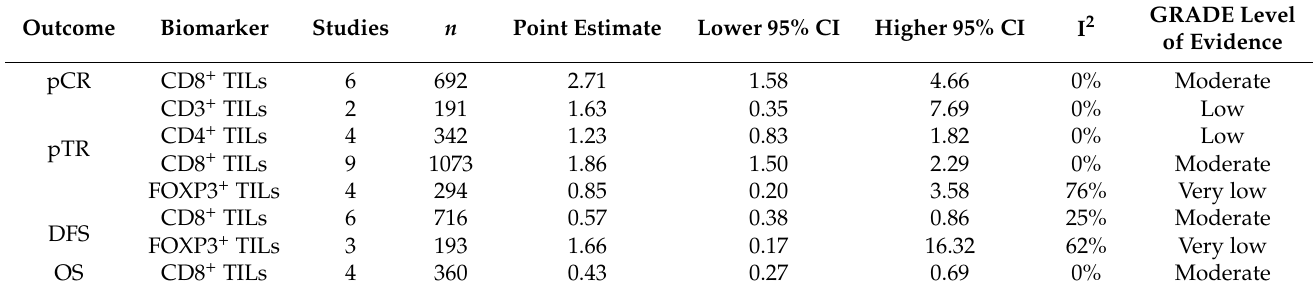
Table 2. This table provides an overview of the results of the meta-analyses including a point estimate of the risk ratio (in relation to pathological response) and the hazard ratio (in relation to survival) with corresponding CI. The level of evidence has also been included in the table. The meta-analyses evaluated the association between pretherapeutic TILs density and treatment response to NCRT and long-term